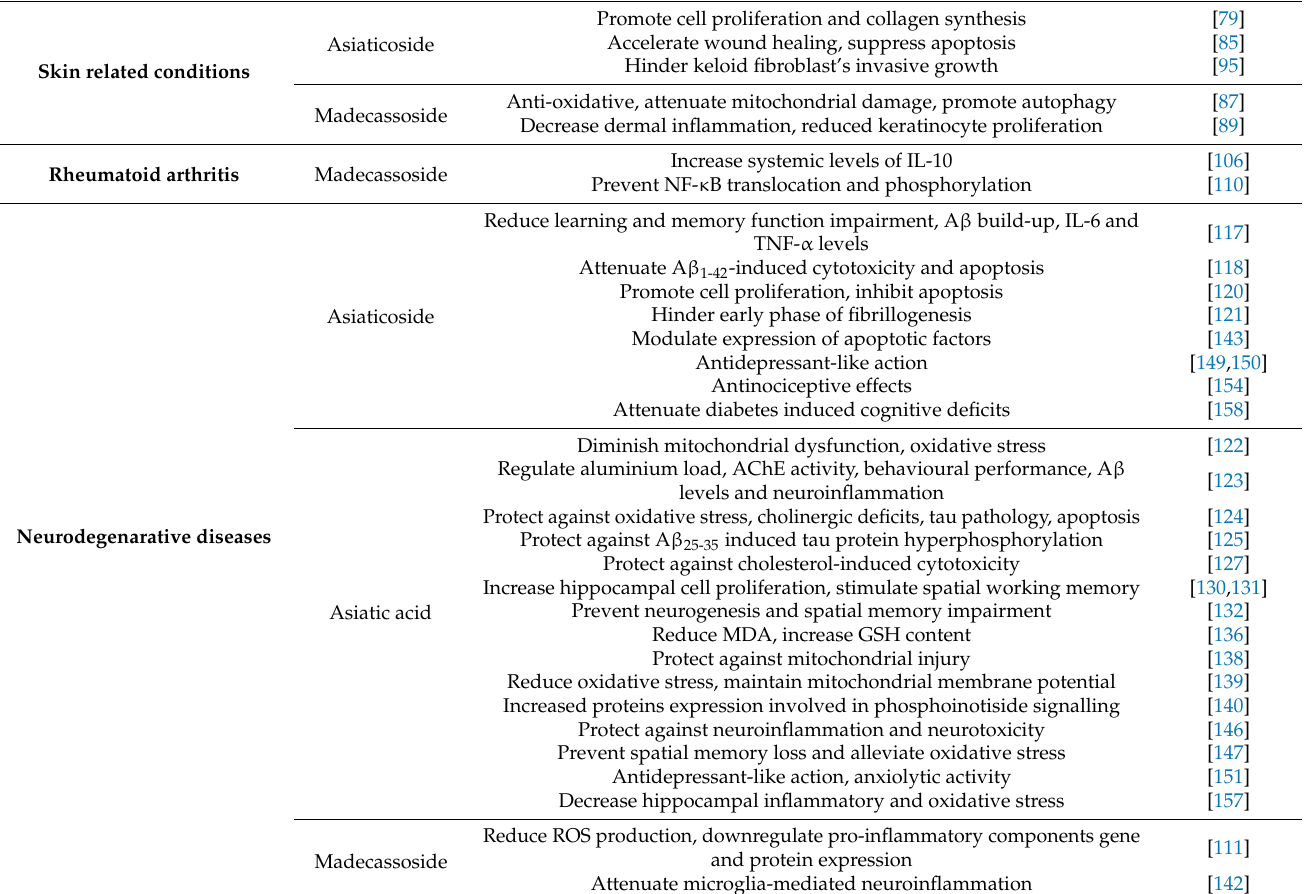
Table 1. A summary of pharmacological activities of all compounds published from year 2015 to 2021.